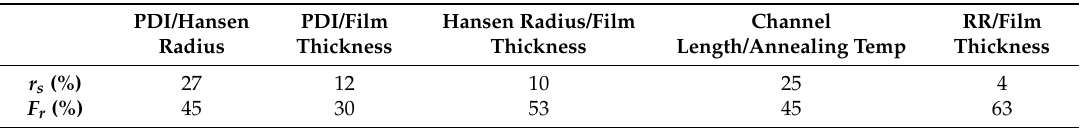
Table 1. Metrics for the two-dimensional analysis of the poly-3-hexylthiophene (P3HT) system. PDI—